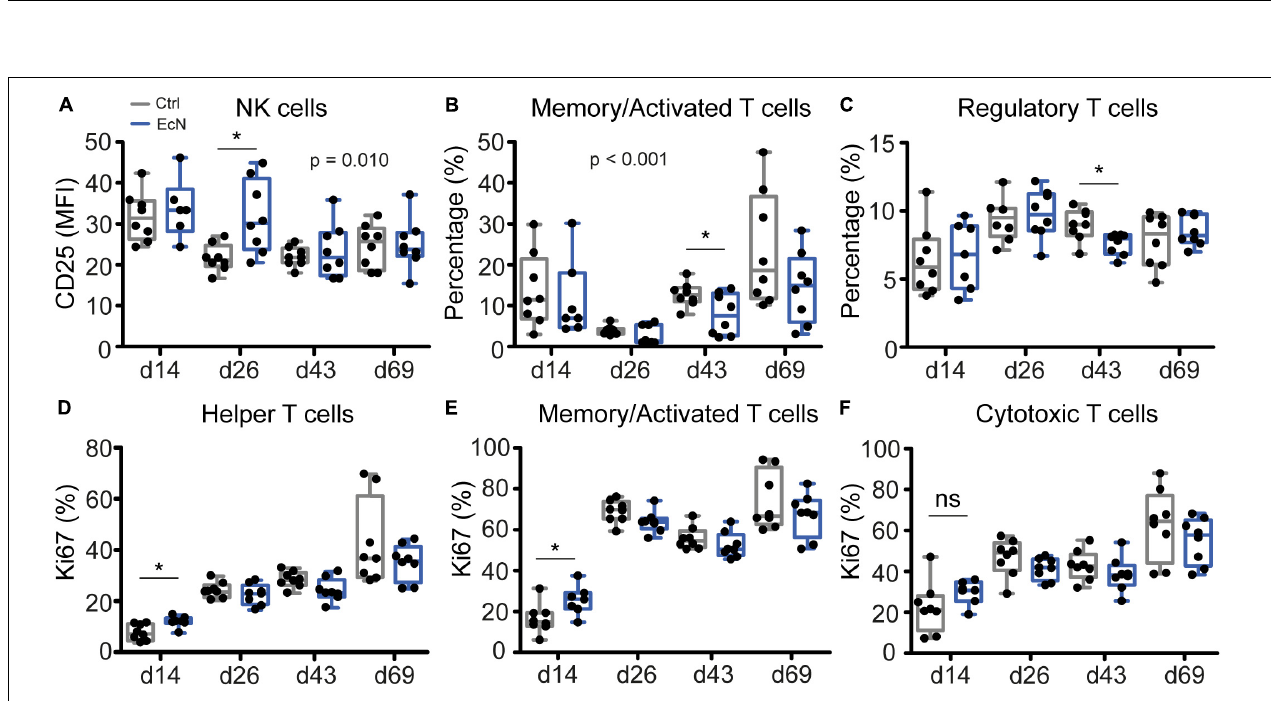
FIGURE 8 | Analysis of innate and adaptive immune cells in PBMCs. P -values indicate significant differences between treatment groups over time (A,B) , and asterisks are used to demonstrate significant differences between treatment groups after taking into account single time points (* p < 0.05, C–E ). Data were presented as the mean fluorescent intensity (MFI; A ), percentage of cells (%; B,C ), or percentage of proliferating cells (Ki67%; D–F ). Every point represents an individual animal from a separate pen ( n = 7 or 8 per treatment group), and error bars represent standard deviations. Normal distribution and equal variances of data were checked and log-transformed when